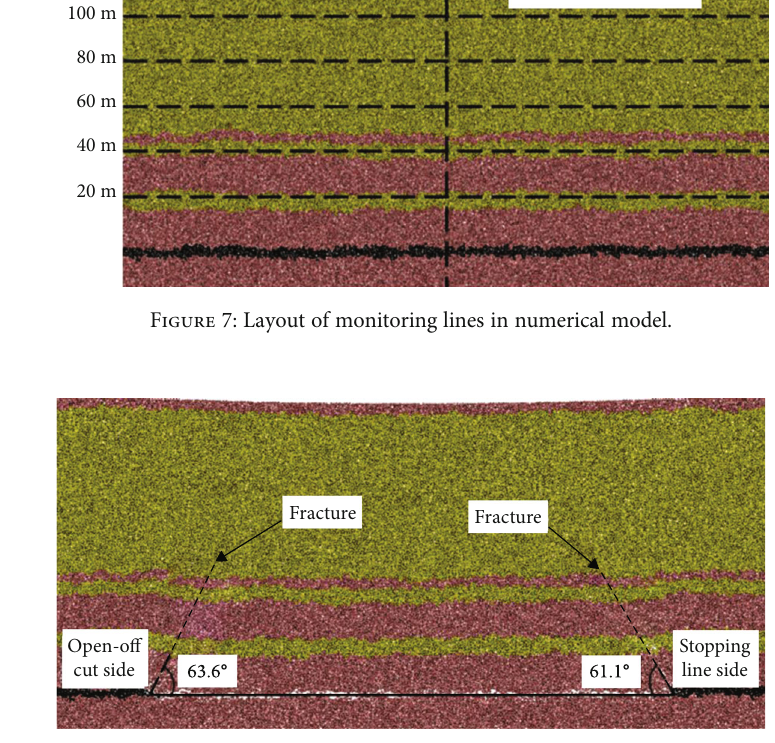
Figure 8: Sketch of fracture propagation in model.